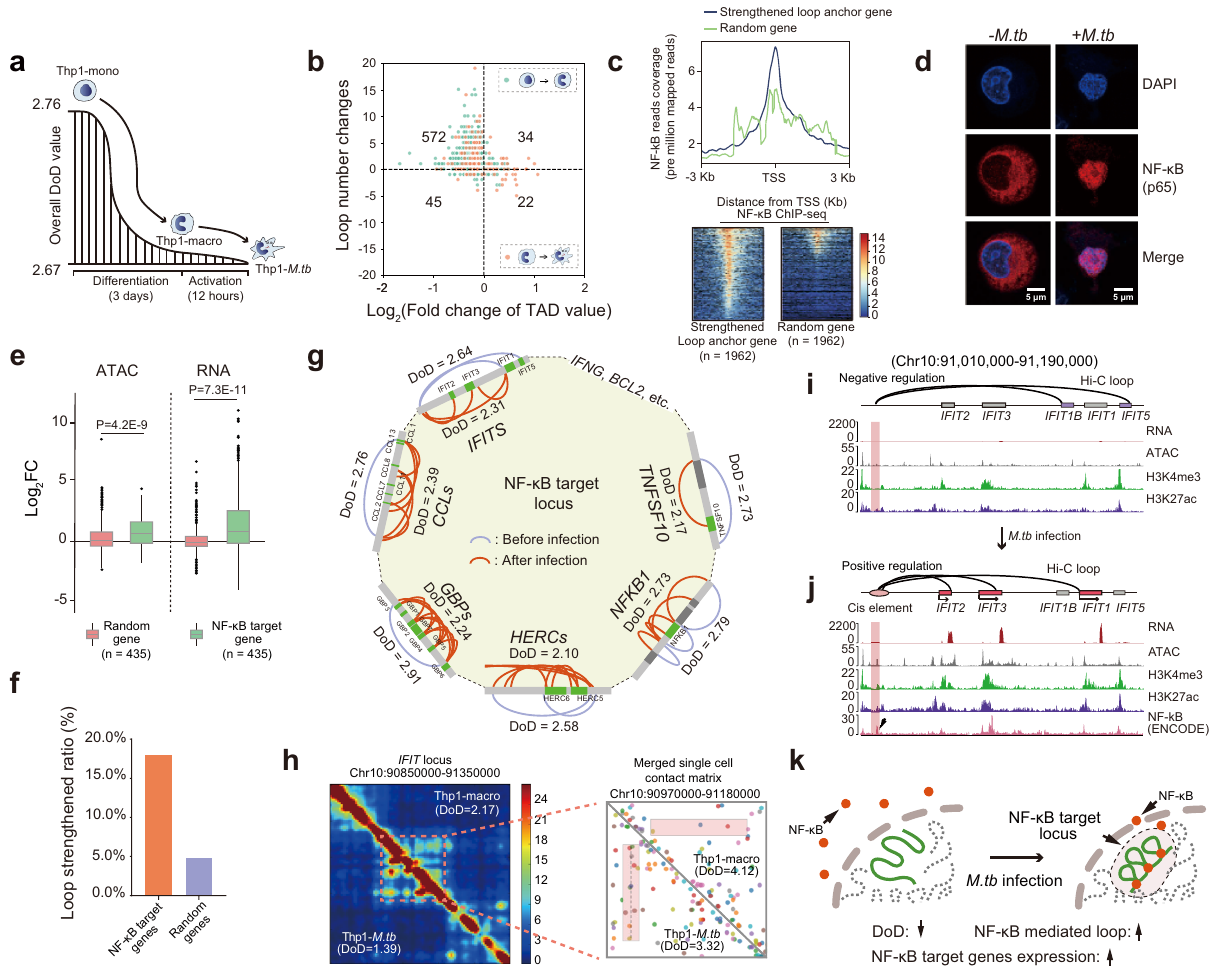
Fig. 5 | Reorganization of chromatin architecture around NF- κ B target gene sites. a Overall TAD DoD of THP-1 cells during differentiation and infection. The y - axis represents the average DoD value of TADs in each state. The data are from Supplementary Fig. 3g. b The relationship between TAD DoD and chromatin loop duringdifferentiationandactivation.The x -axisrepresentslog 2 foldchangeofTAD DoD value, and the y-axis represent the number of loop changes in each TAD. c Compare NF- κ B enrichment around transcription start site (±3kb) between strengthenedloopanchorgeneandrandomcontrolgene.Thegeneintheheatmap weresortedaccordingtotheenrichmentintensityofNF- κ B.ChIP-seqdataarefrom ENCODE (GM12891 cell line). d Immuno fl uorescence analysis of NF- κ B (p65) sub- cellular location before and after M.tb infection. Each experiment was replicated three times. e Log 2 foldchanges of ATACpeaks and RNA expression level of NF- κ B target genes and random control genes. Box-plot with midline=median, box